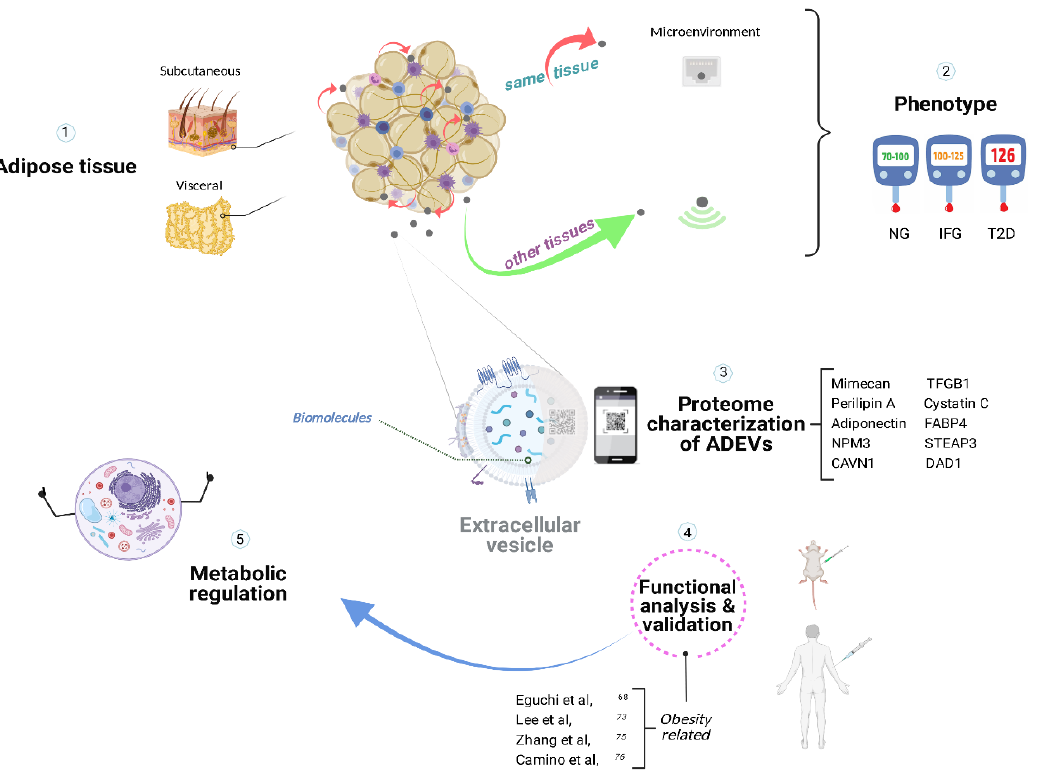
Figure 1. Metabolic homeostasis with the assistance of adipose-derived extracellular vesicles. Adipose tissue secretes extracellular vesicles that could participate in pathophysiological processes specific to the microenvironment in a paracrine manner and communicate with other tissues in an endocrine-like fashion, likely being involved in the progression of insulin resistance and type 2 diabetes. The proteomic analysis of ADEVs’ contents served to characterize the molecular fingerprint, providing potential biomarkers for diagnosis and personalized treatments for obesity-related diseases. ADEVs, adipose-derived extracellular vesicles; NG, normoglycemia; IFG, impaired fasting glucose; T2D, type 2 Diabetes. Created with BioRender.com (accessed on 25 May 2022).